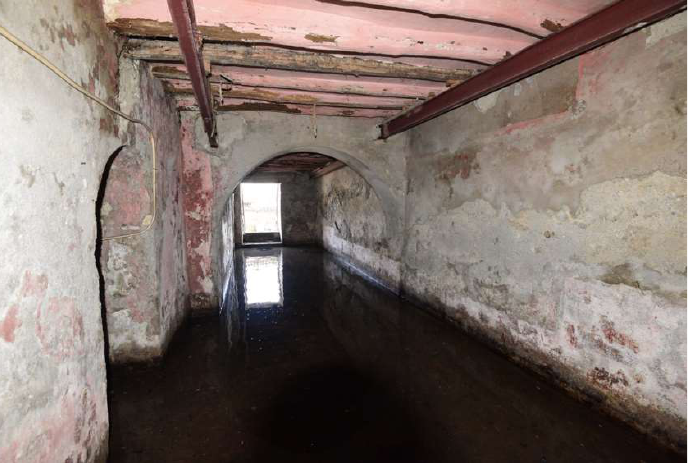
Figure A11. Flooded ground floor in a building along the coast of Marina Lunga. Until the 1980s, it was used as warehouse, but later, it was abandoned due to sea level rise. Presently, the ground floor is below the local sea level.